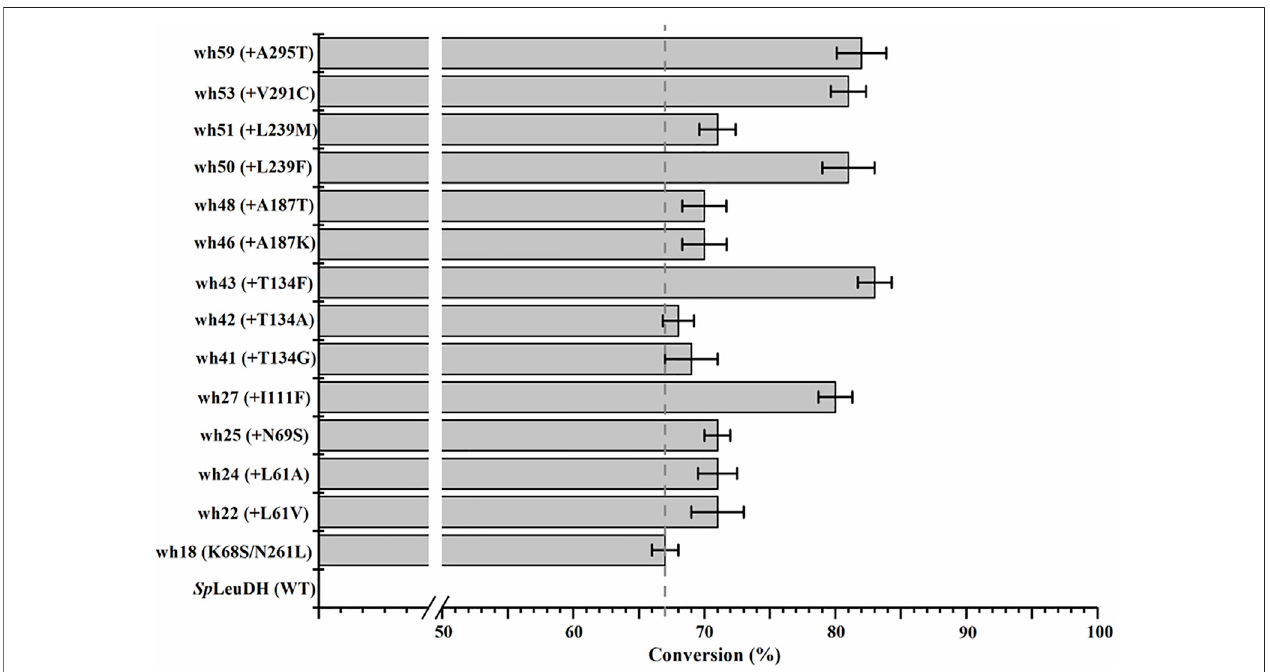
FIGURE 2 | Improved variants obtained by screening the single point saturation mutagenesis libraries on the 27 positions. Reductive amination reactions were performed in a reaction mixture (0.5 ml) containing 1 M NH 4 Cl/NH 3 · H 2 O buffer (pH 8.5), 1 mM NAD + , 100 mM glucose, 2 mg/ml GDH cell-free extract (CFE), 6 U/ml DNase I, 20 mM 1a, and 20 mg/ml mutant CFE at 30 ° C, 1,000 rpm for 24 h. The conversion was detected by HPLC at least three times.